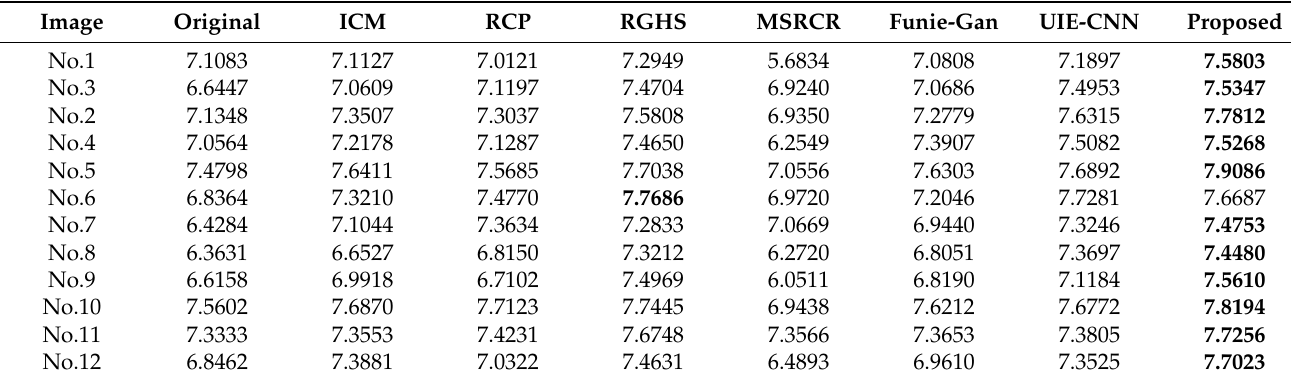
Table 7. Evaluation of processed images by information